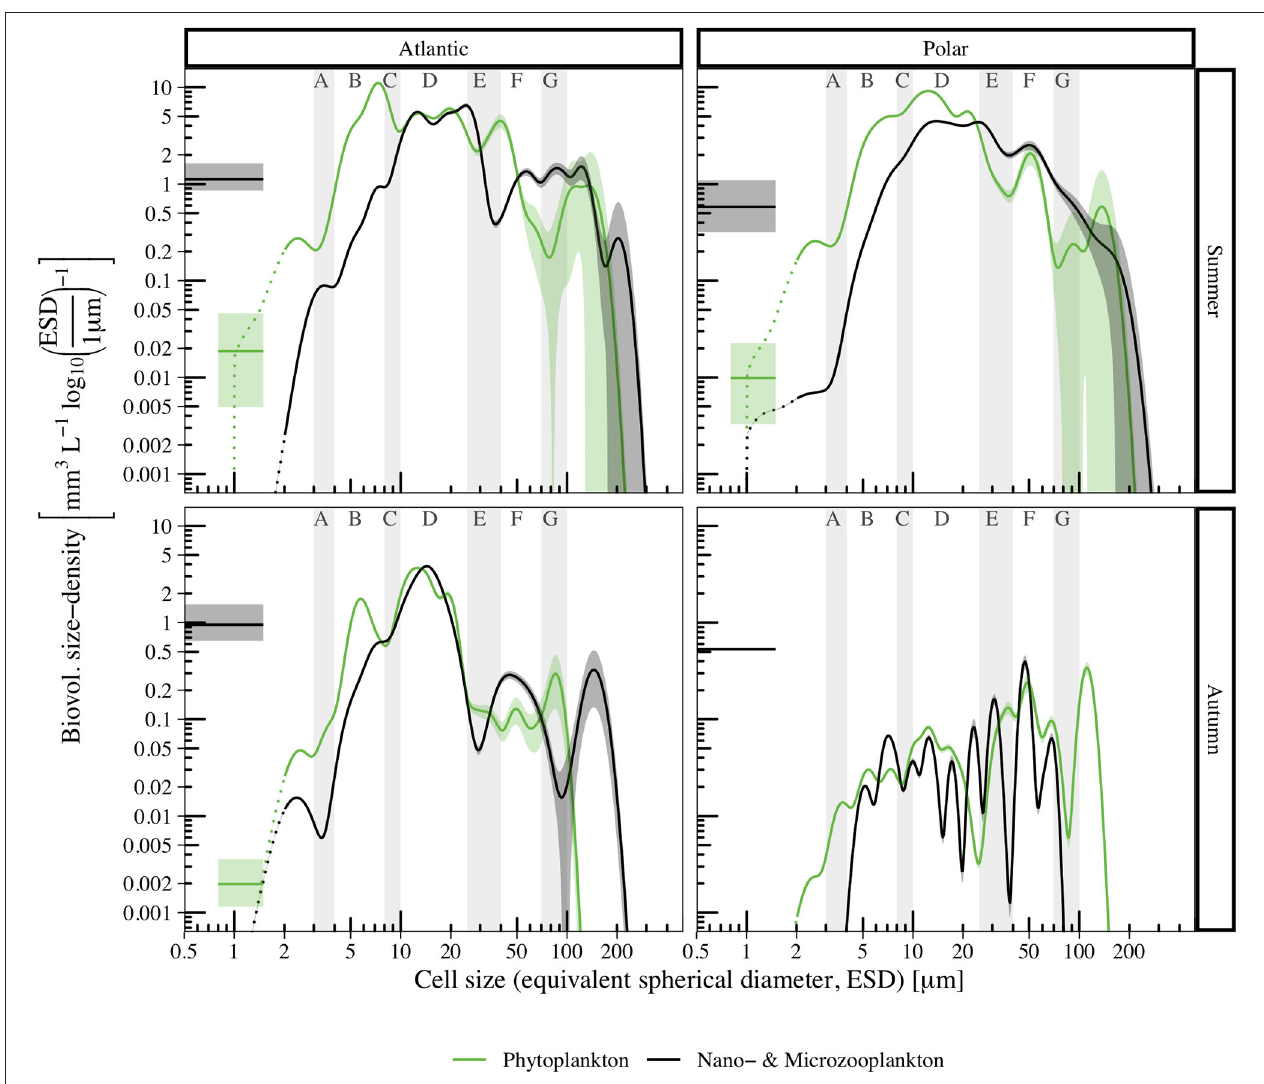
FIGURE 7 | Biovolume size spectra for phyto- (green) and microzooplankton (black) of temporally (summer, top panels; autumn, bottom panels) and spatially (Atlantic, left panels; Polar, right panels) separated data. Colored shaded areas indicate the 95% confidence intervals, dotted lines indicate reduced reliability of size measurements for cells with ESD < 2 µ m. For comparison, biovolume concentration densities derived from Flow Cytometry cell count measurements are shown for bacteria (black line, 0.5–1.5 µ m, assuming mean ESD 1 µ m, data from corresponding samples in von Jackowski et al. (2020) and for Synechococcus (green line, = 0.8–1.5 µ m, assuming mean ESD 1.2 µ m, data from Paulsen et al., =